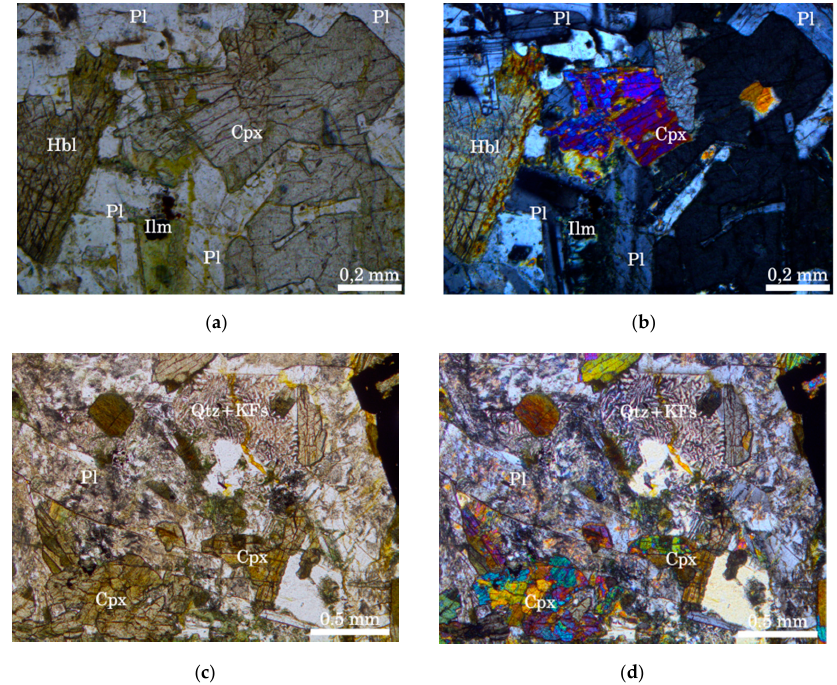
Figure 3. Photographs of thin sections in transmitted light (left column without analyzer,